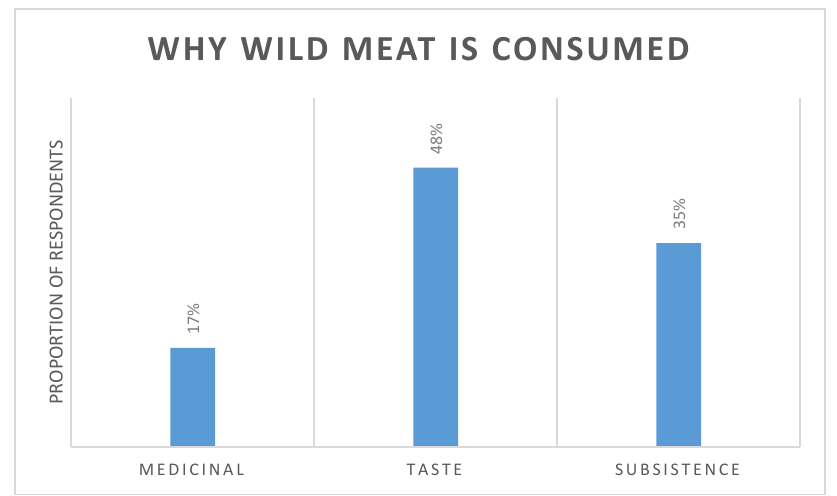
Figure 4. Distribution of responses regarding the reasons for consumption of wild meat in communities adjacent to Bardia National Park, Nepal. ( n = 42).